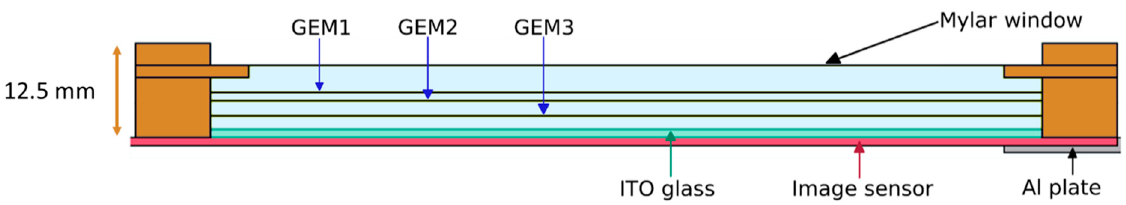
Figure 1. Schematic drawing of the LaGEMPix (to scale). Electrons produced in the drift gap between the Mylar window and the top GEM (GEM1) are multiplied in the triple-GEM stack and collected on the transparent indium tin oxide (ITO) glass anode. Scintillation photons of certain wavelengths pass through the ITO glass and are detected by the image sensor.